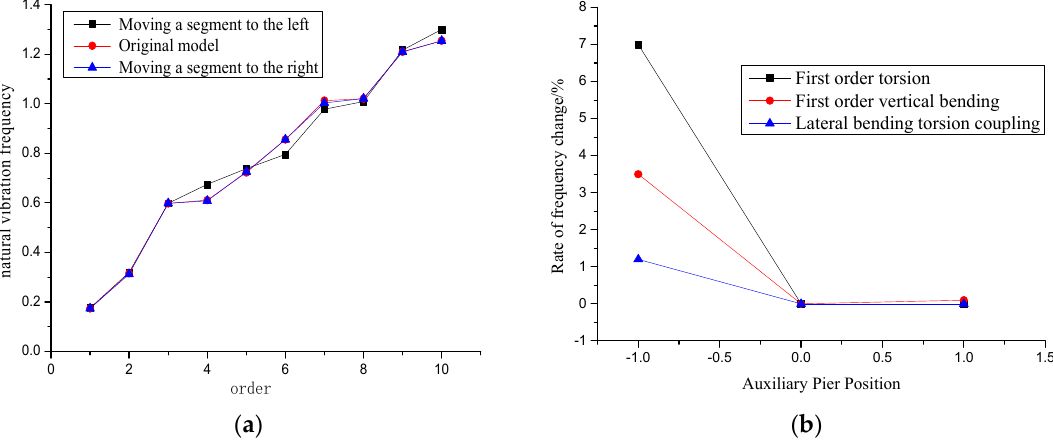
Figure 10. Influences of auxiliary piers: ( a ) Influence of auxiliary pier position on the first ten order natural frequencies; ( b ) the influence of auxiliary pier position on three key modes.